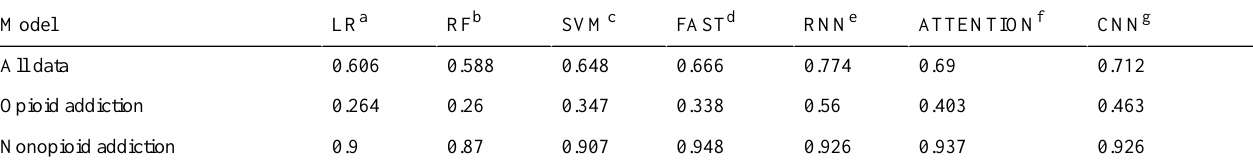
Table 6. Model prediction accuracies with heuristic labels determined by the keyword presence.